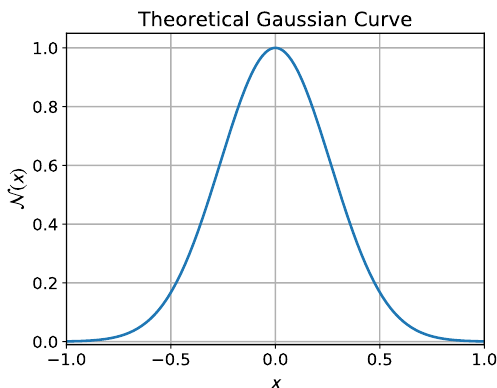
Figure 2. Theoretical Gaussian Function